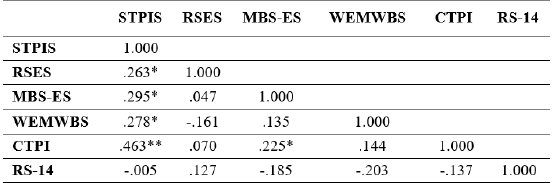
ity: Correlation